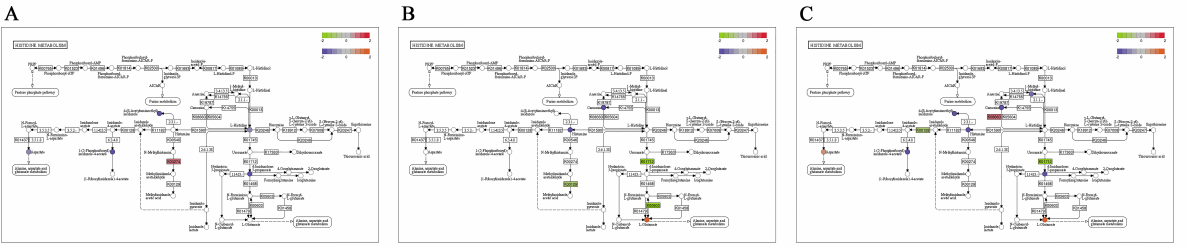
Figure 12. The pathway of histidine metabolism. ( A ) E15_BM vs. E21_BM; ( B ) E21_BM vs. E27_BM; ( C ) E15_BM vs. E27_BM.